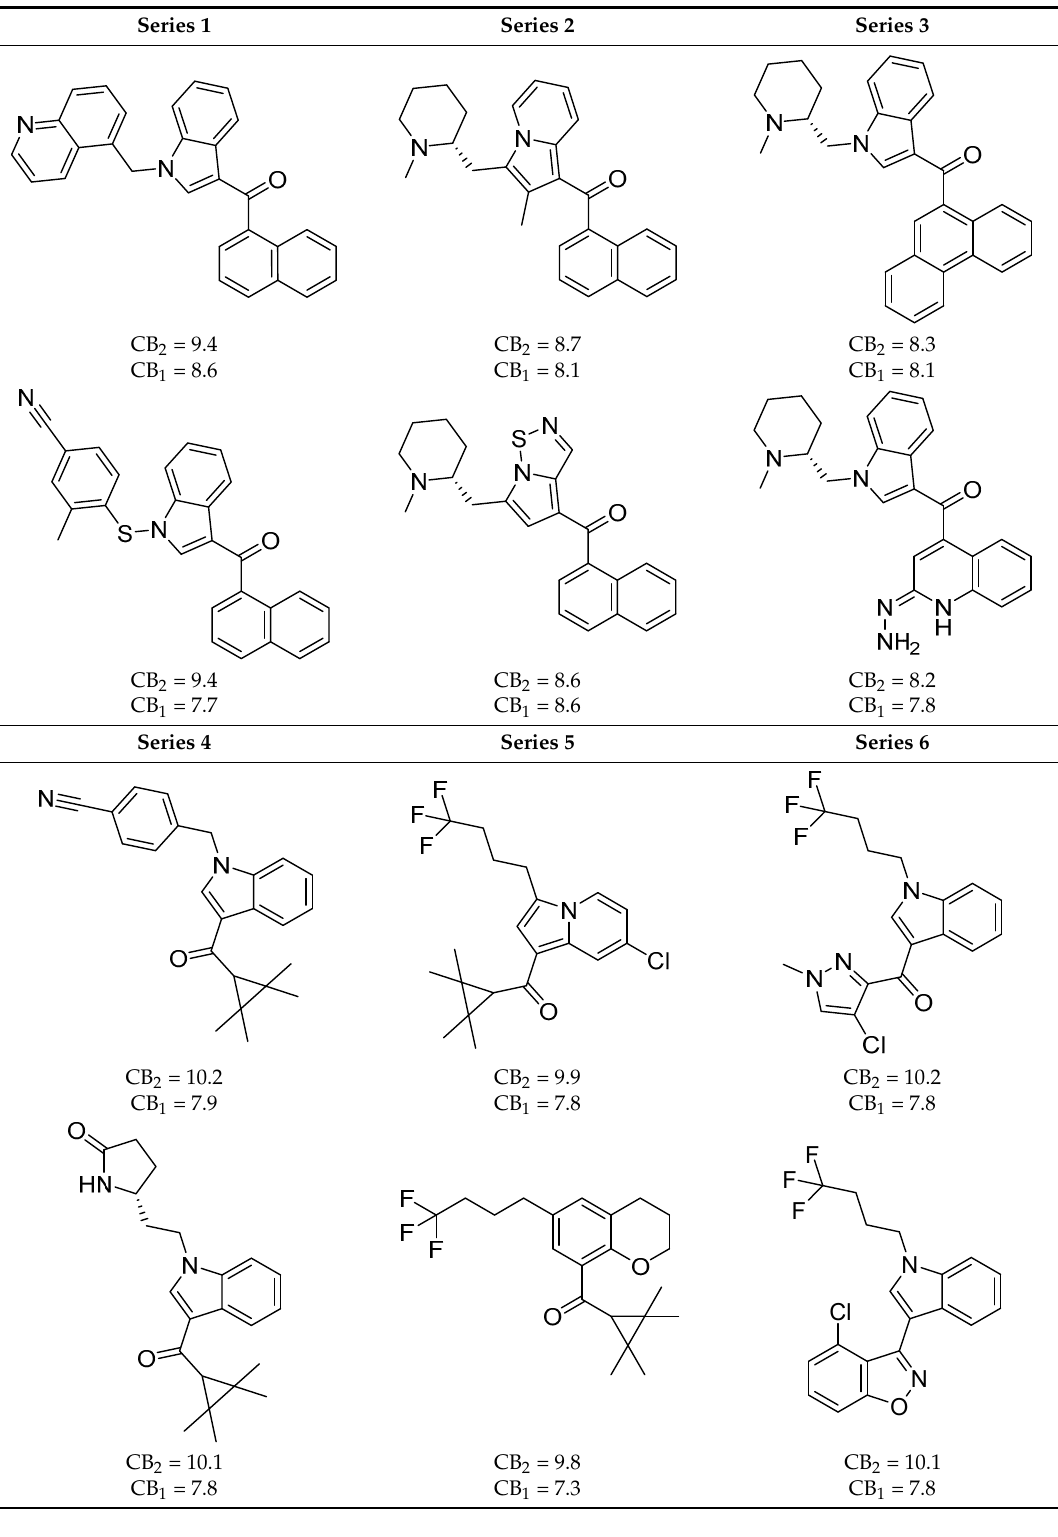
Table 2. Chemical structures of the most potent compounds derived from the bioisosteric replacement for the CB 2 receptor, the predicted K i value are presented as p K i .